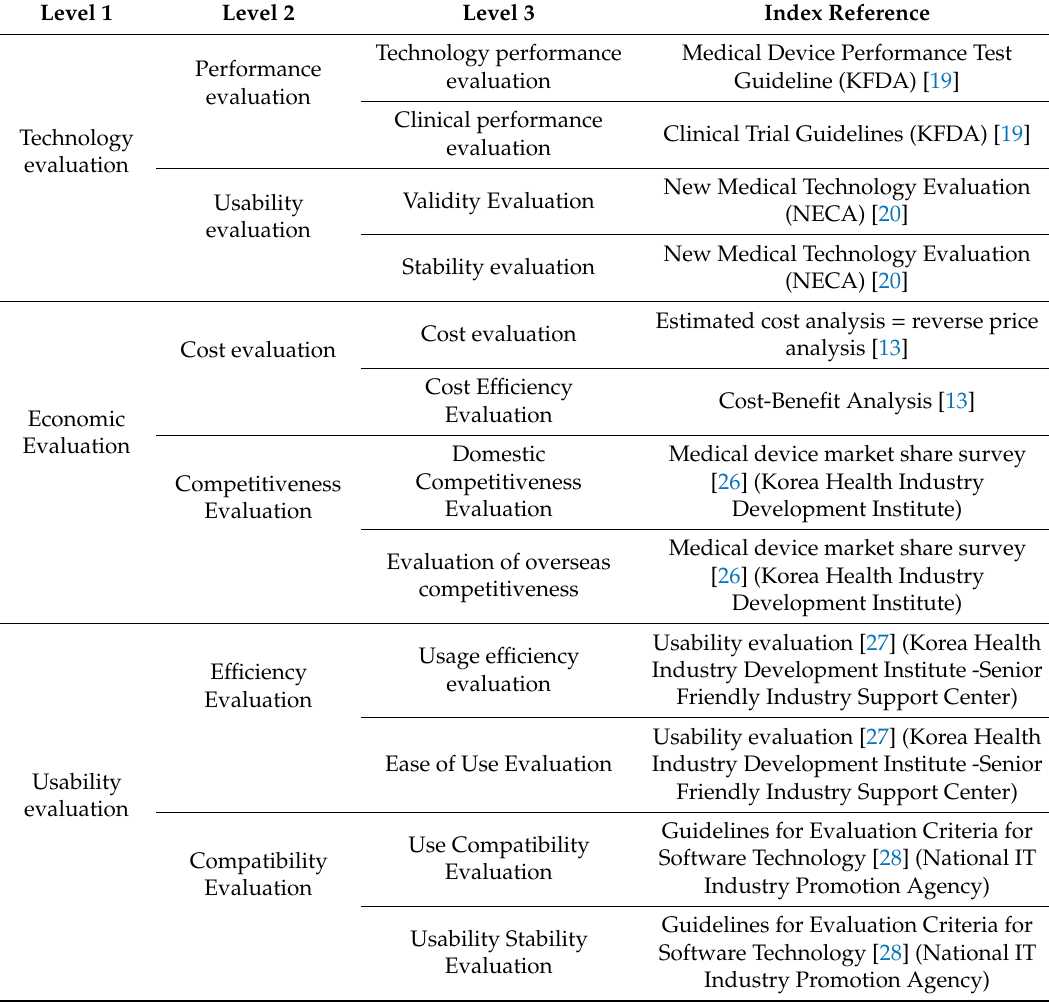
Table 4. Evaluation framework for optimal selection of medical